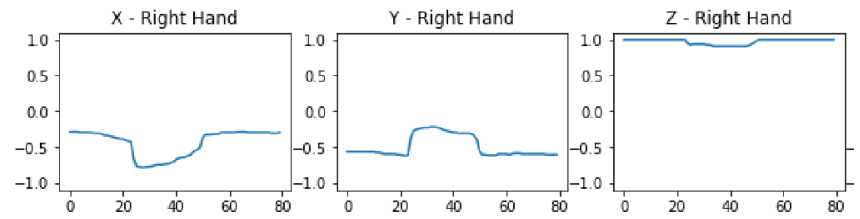
Figure 3. Raw data from right hand joint during Jirugui